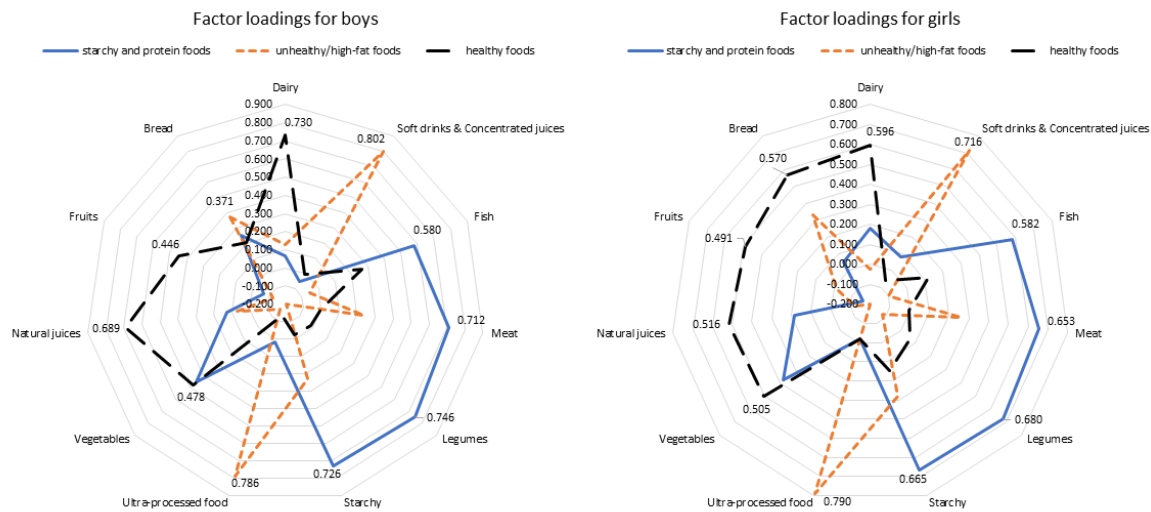
Figure 1. Results from exploratory factor analysis that evaluated children’s dietary habits, split by gender (the extraction method used was the Principal Component Analysis and the rotation method was the varimax with Kaiser normalization).